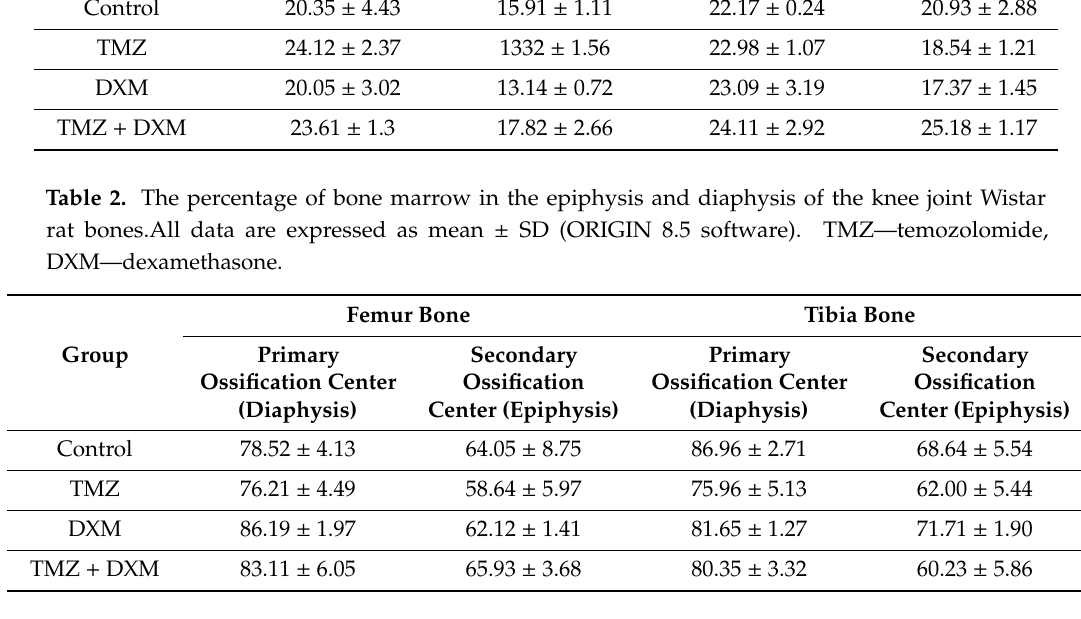
Table 3. Quantitative analysis of the epiphyseal cartilage zones of the Wistar rats knee joint. All data were expressed as mean ± SD (ORIGIN 8.5 software). * p < 0.05, ** p < 0.01, *** p < 0.001 compared